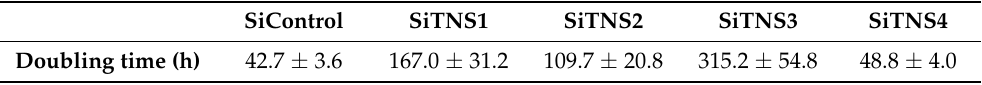
Table 1. Population doubling time after inhibition of